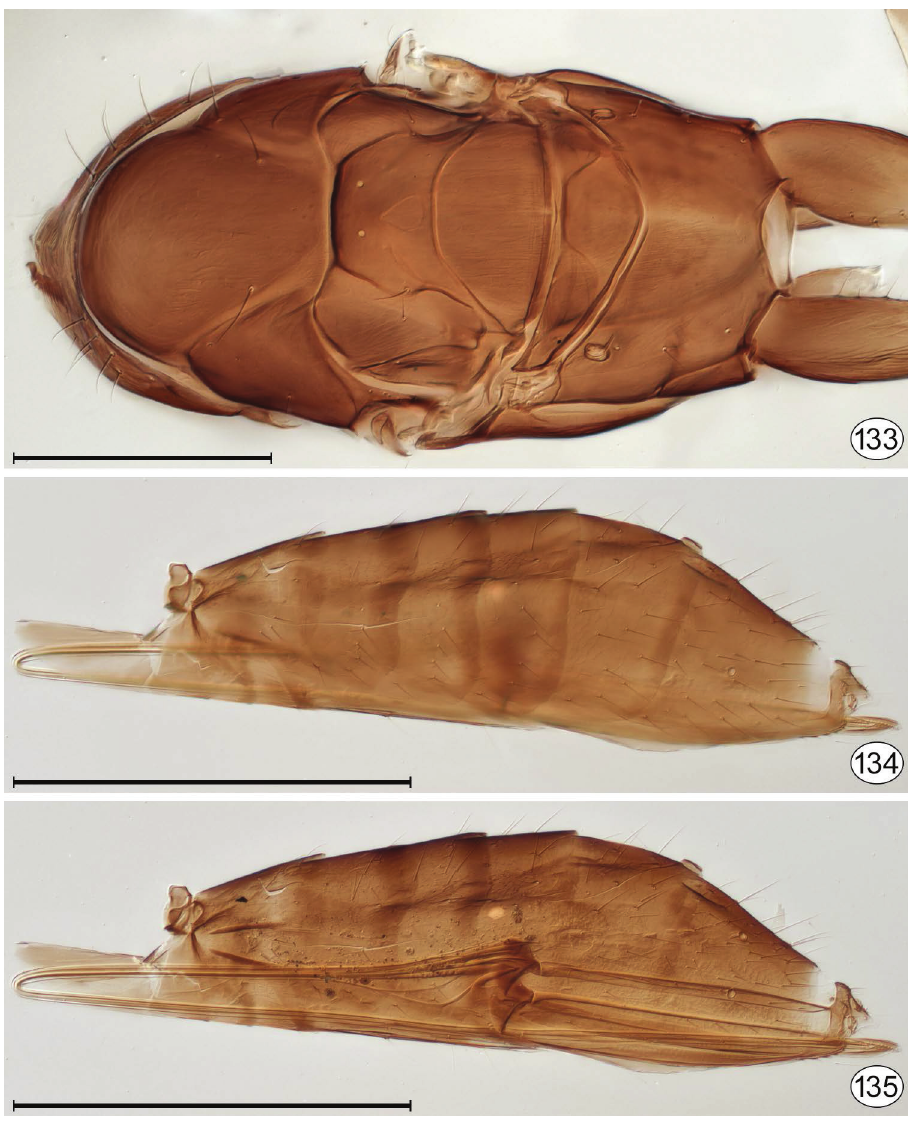
Figures 133–135. Neotriadomerus powerae , holotype. 133 mesosoma, dorsal 134 mesosoma, lateral 135 mesosoma, median plane. Scale bar for 133 = 200 μm; 134, 135 = 500